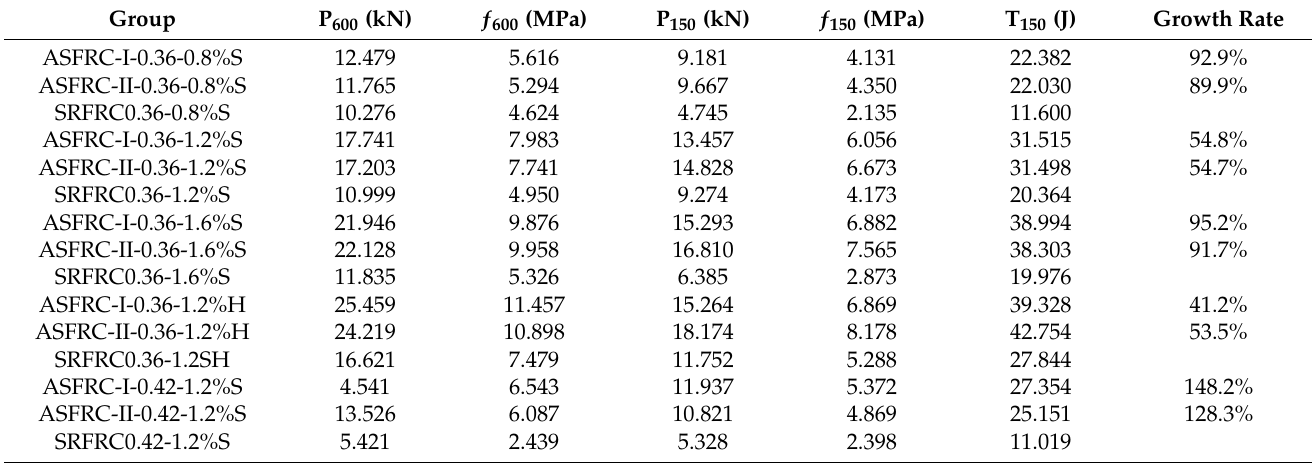
Table 5. Toughness index of steel-fiber-reinforced cement-based unidirectional slab specimens.